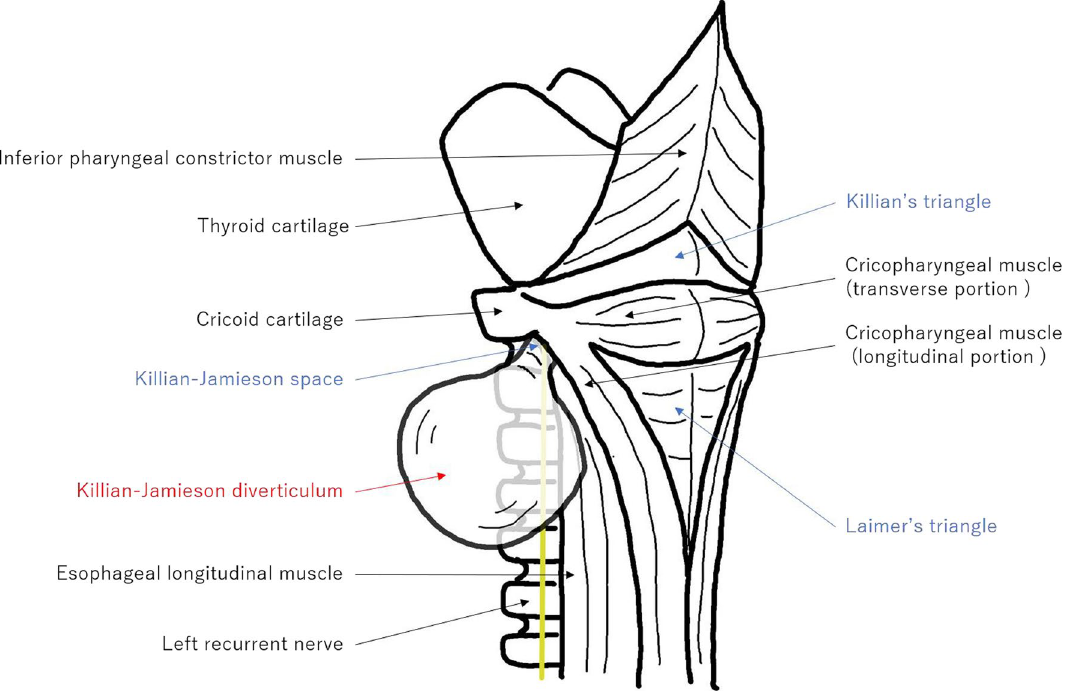
Fig. 3 Anatomy of the hypopharynx and cervical